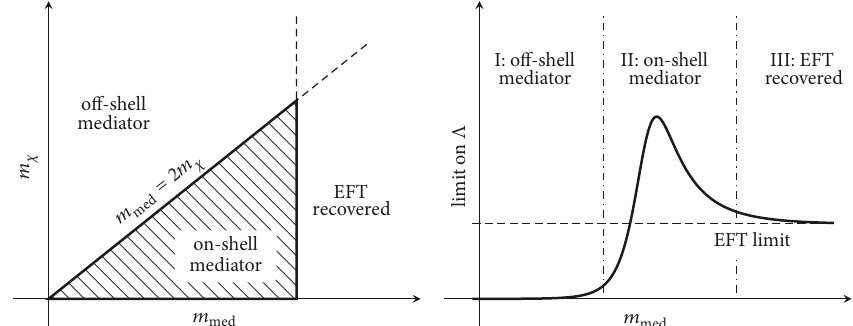
Figure 3: Left: sketch of the limits obtained from mono-X analysis in the 𝑚 med −𝑚 𝜒 plane ( left , adapted from [32]) and in the 𝑚 med −Λ plane ( right , adapted from